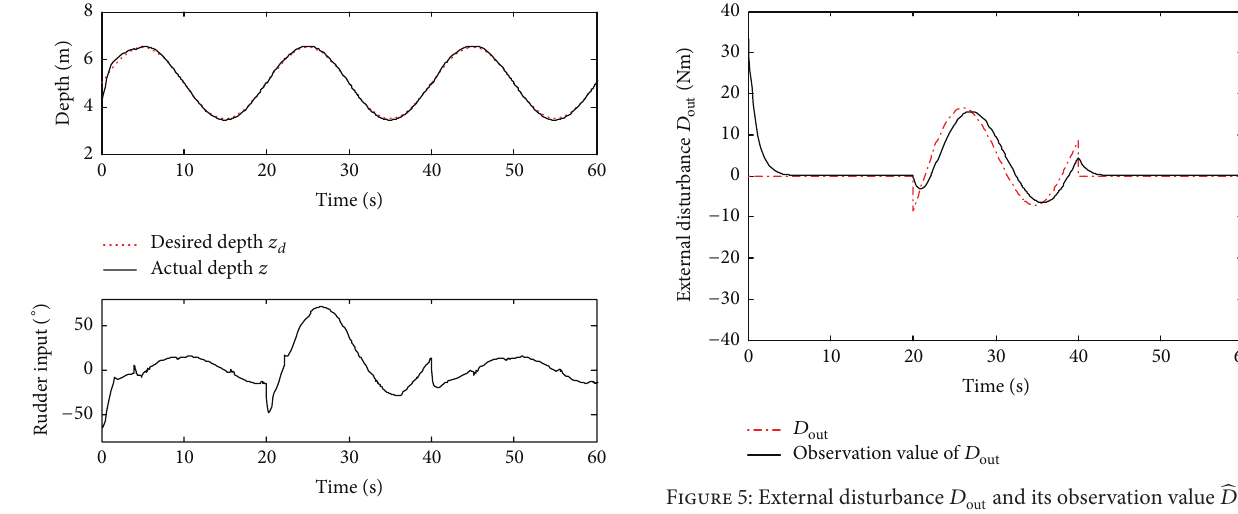
Figure 5: External disturbance 𝐷